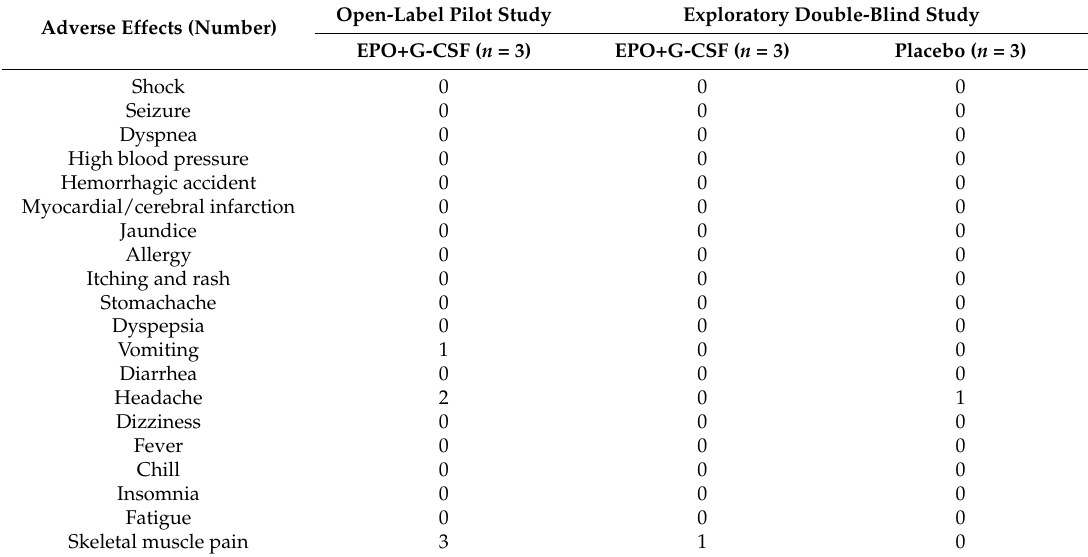
Table 4. Adverse events from EPO+G-CSF administration in all